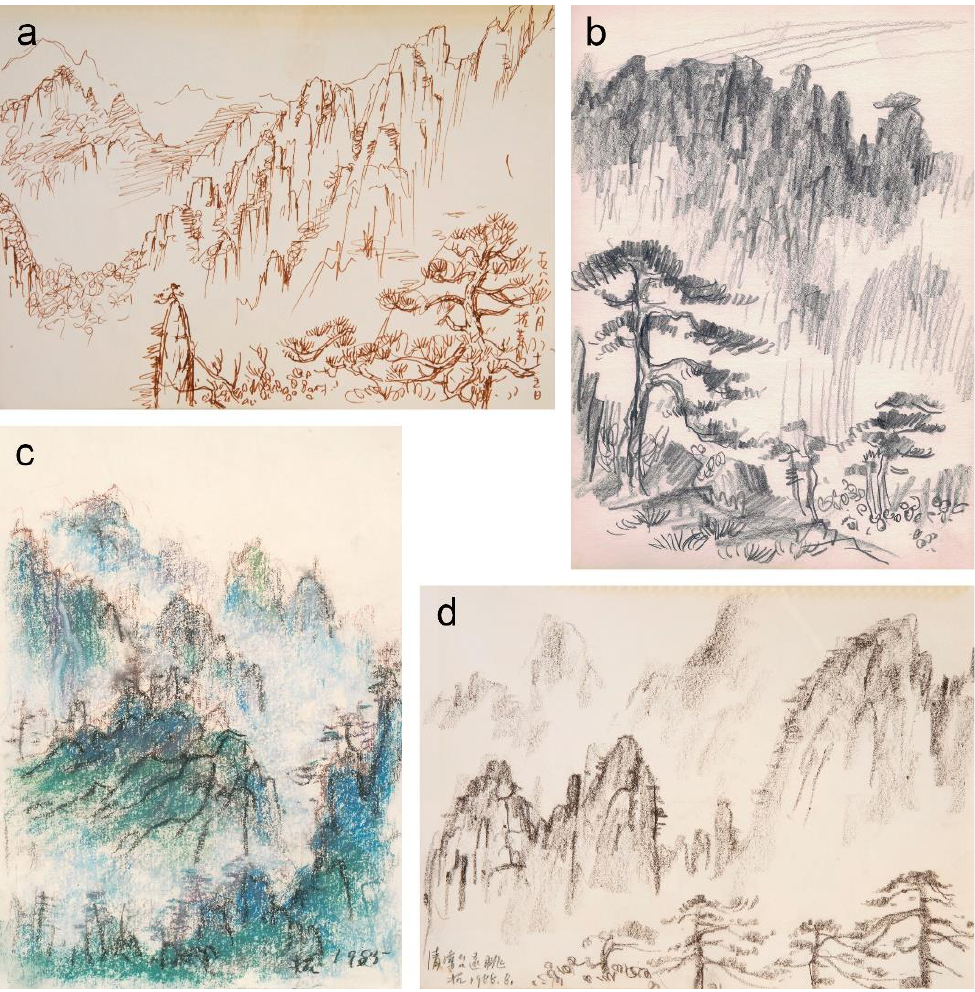
Figure 17. ( a ) Liu Kang, Mount Huangshan , 1988, pen on paper, 35 × 25.5 cm; ( b ) Liu Kang, Mount Huangshan , 1970s, pencil on paper, 18 × 25 cm; ( c ) Liu Kang, Mount Huangshan , 1985, pastel on paper, 35 × 25 cm; ( d ) Liu Kang, Mount Huangshan , 1988, charcoal on paper, 35 × 25.5 cm. Images ( a , d ) are from Liu Kang family collection. Images courtesy of Liu family. Images ( b , c ) are gifts of the artist’s family. Collection of National Gallery Singapore.